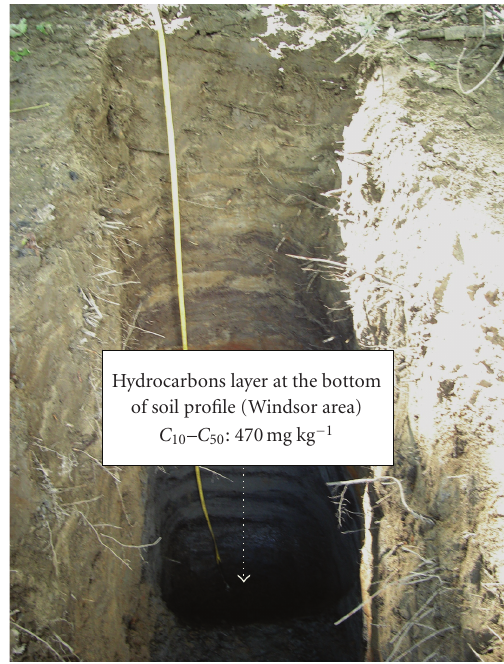
Figure 2: Soil profile with the hydrocarbon layer (C 10 –C 50 ) at a depth of 160–180 cm. The contaminated layer can be more than 30cm thick in the riverbank in the Windsor area (left